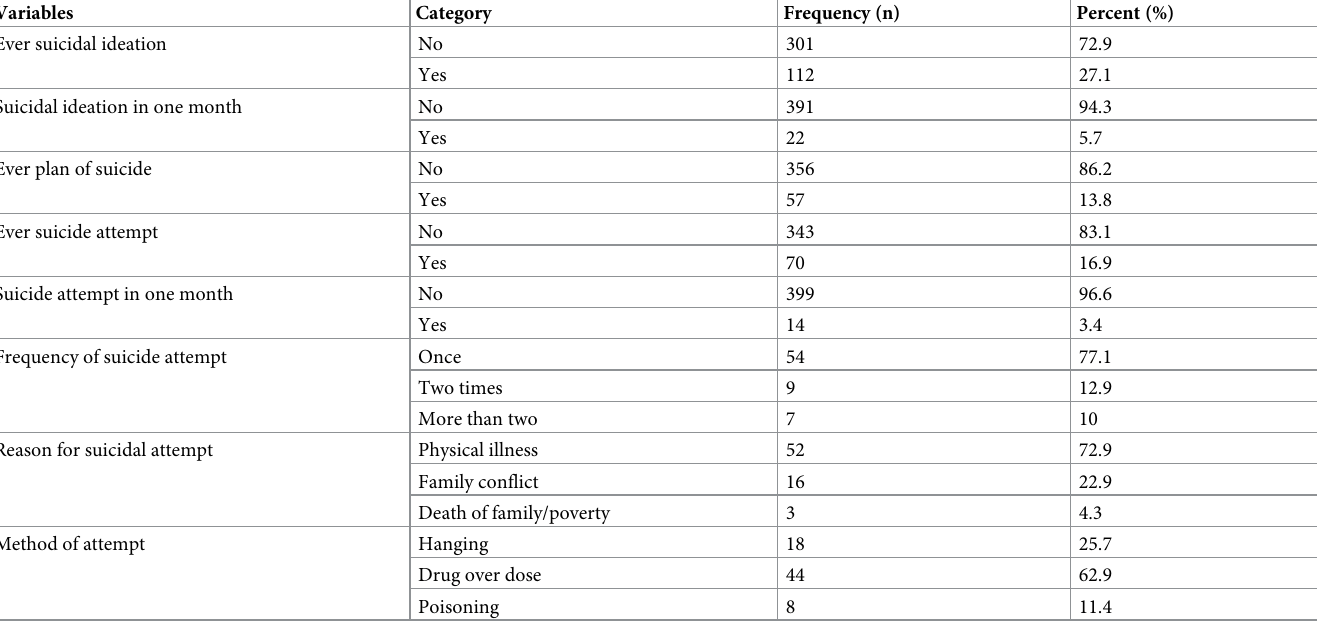
Table 3. Suicidal ideation and attempt among respondents at SPSH and SPHMMC Addis Ababa, Ethiopia, 2018 (n =